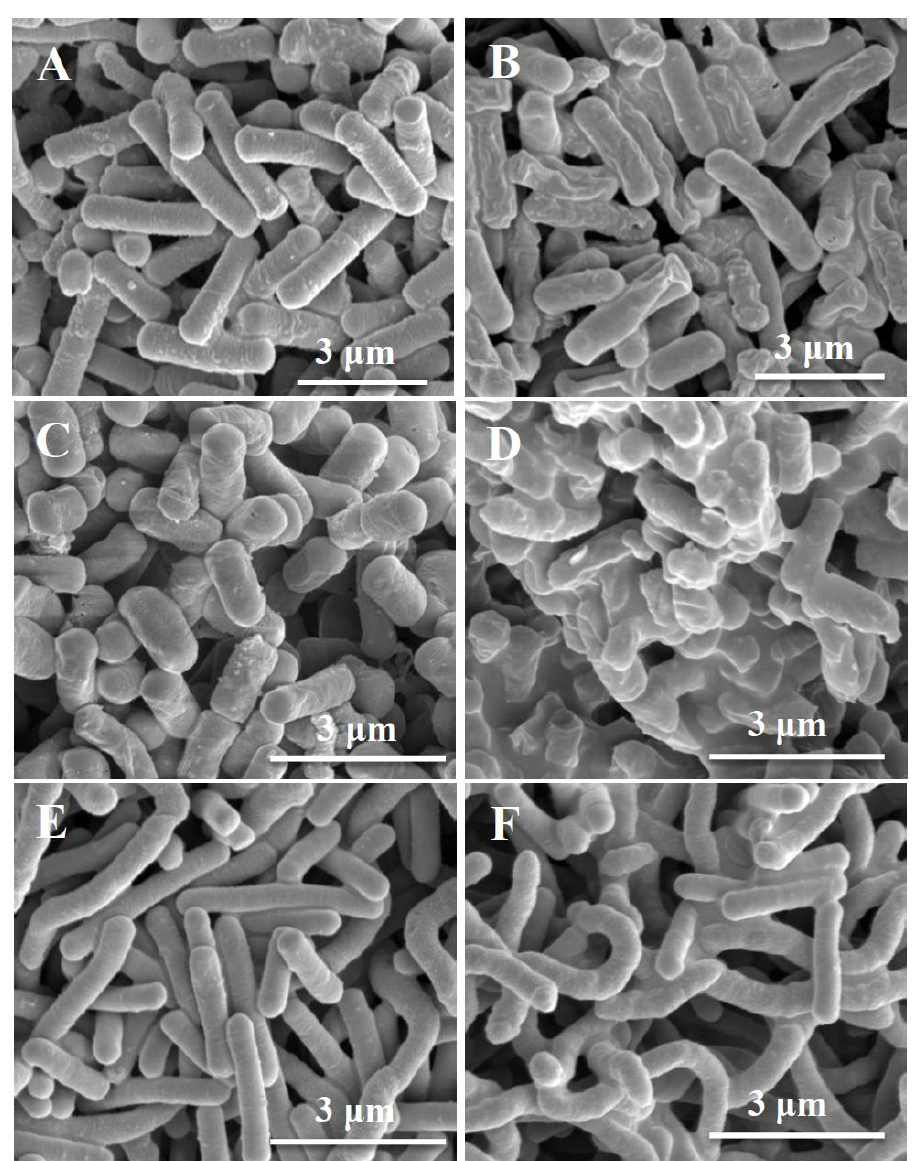
Figure 2. Scanning electron photomicrograph of untreated ( A ) and treated ( B ) Klebsiella pneumoniae , untreated ( C ) and treated ( D ) Moraxella spp., untreated ( E ) and treated ( F ) Legionella pneumophila with 25 μg/mL CSA -131.